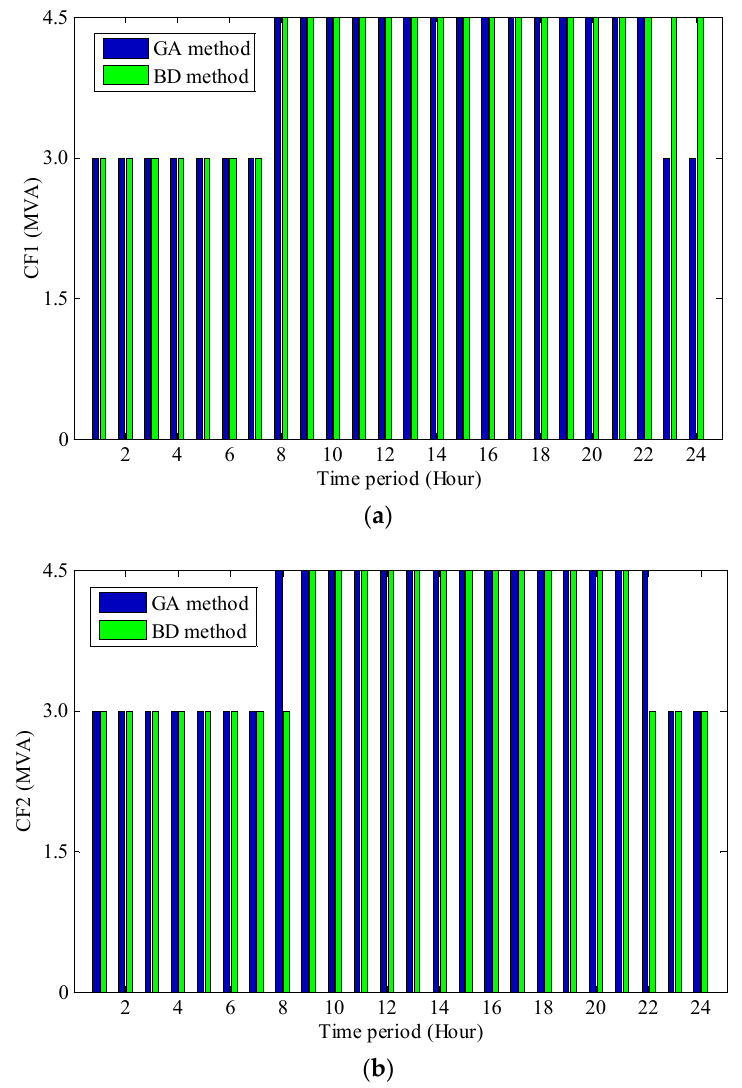
Figure 8. Capacities of capacitor units of different methods: ( a ) capacitor unit C F1 at Node 4; and ( b ) capacitor unit C F2 at Node 9. Table 5. Optimization results of a random day.